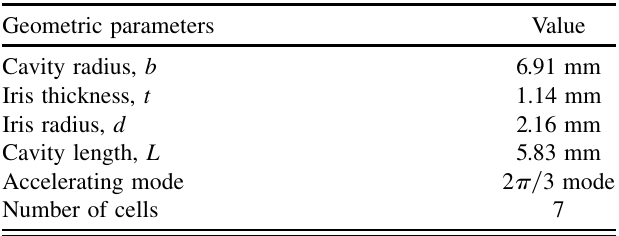
TABLE IV. Dimensions of the DLW